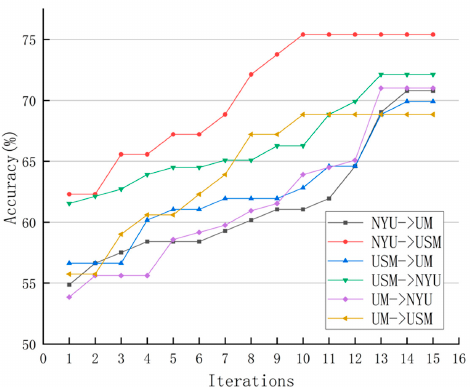
Figure 1. Classification accuracy versus the number of iterations on six domain pairs. In addition, the values of α and β involved in the experiment represent different decision risk cost levels, and their slight differences may induce different decision results. Without any loss of generality, in order to obtain more suitable parameters, we analyze the influence of different threshold parameters on the performance of the proposed